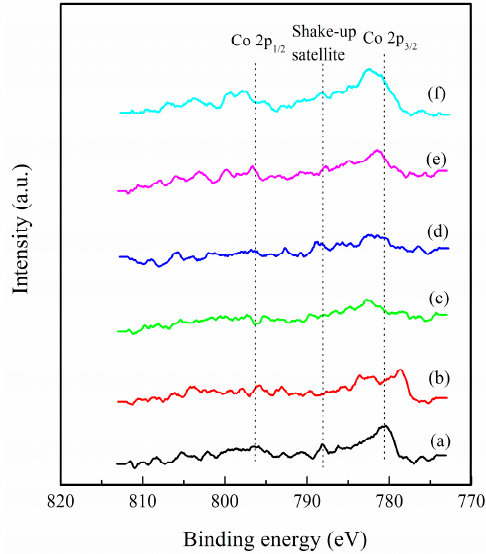
Figure 5. XPS spectra of the Co 2p regions for fresh, deactivated, and regenerated catalysts. ( a ) Co-Zn/H-Beta-F, ( b ) Co-Zn/H-Beta-D, ( c ) Co-Zn/H-Beta-R (H 2 + O 2 , 450 ◦ C), ( d ) Co-Zn/H-Beta-R (O 2 + H 2 , 450 ◦ C), ( e ) Co-Zn/H-Beta-R (O 2 + H 2 , 500 ◦ C), ( f ) Co-Zn/H-Beta-R (O 2 + H 2 , 550 ◦ C).